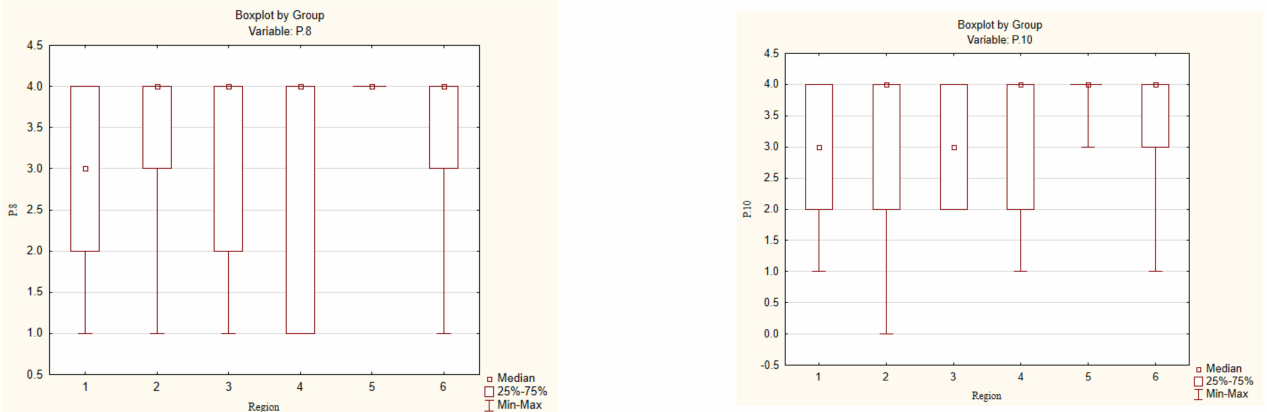
Figure 5. Box and whisker diagrams for practice P8 (Turning off lights in empty rooms) and P10 (Turning off the TV when people are not watching), the category “energy saving”.